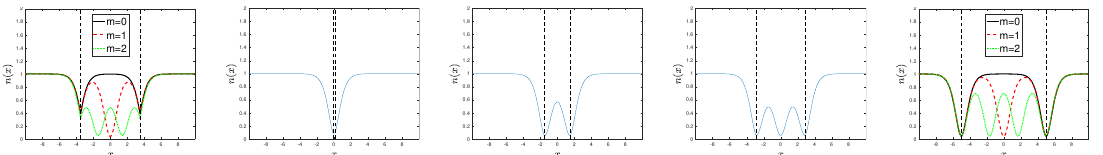
Figure 6. Density profile of the symmetric solutions for the double-delta configuration. The vertical dashed lines mark the limits of the cavity. Left panel: m = 0,1,2 S + solutions for v = 0.2 and X = 7. Central panels: m = 0,1,2 S − solutions for v = 0.2 and X = 0.25,3,5.76, respectively. Right panel: m = 0,1,2 SD solutions for v = 0.2 and X =